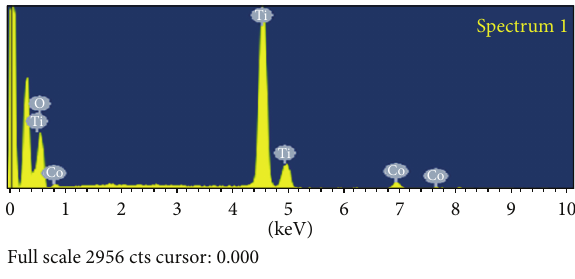
Figure 5: TEM image of 1% cobalt doped TiO 2 . Table 2: COD data of Fe, Mn, and Co doped TiO